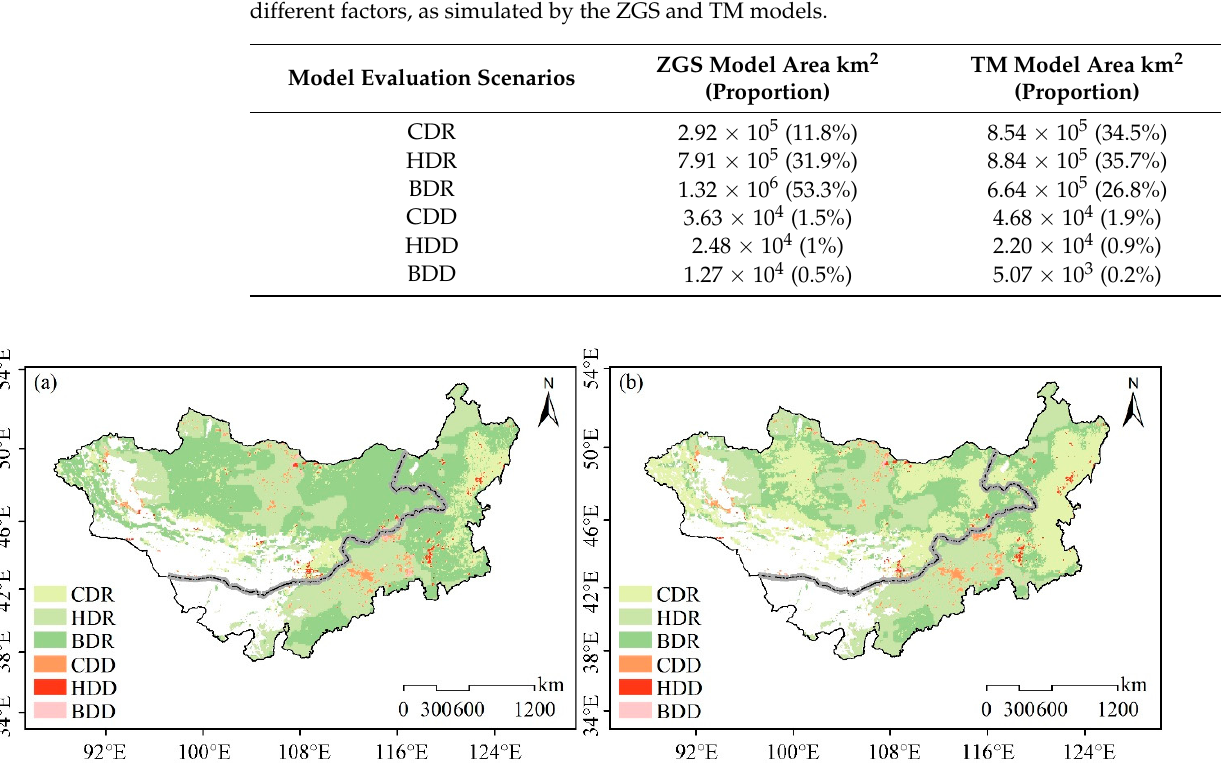
Figure 8. Relative effects of climate change and human activity on vegetation restoration and degradation: ( a , b ) represent the results of ZGS model and TM model, respectively.